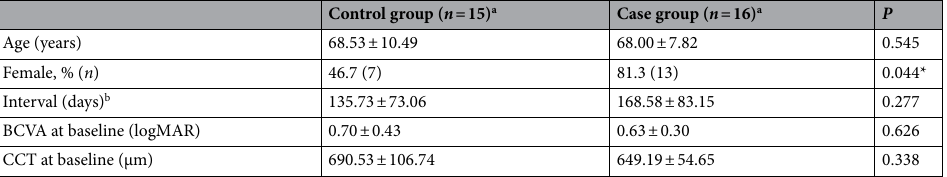
Table 1. Baseline Characteristics. a All values are presented as mean ± SD unless otherwise noted. b Interval defined as time between transplantation registry to DMEK in the control group, and time between cataract surgery and DMEK in the case group. BCVA, best corrected visual acuity; CCT, central corneal thickness.